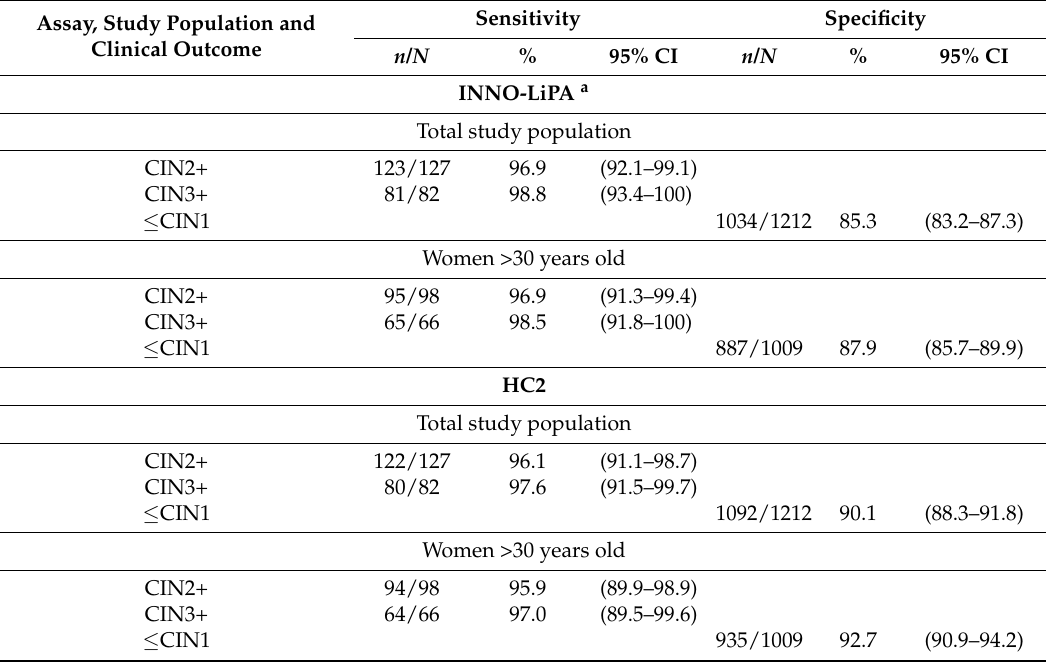
Table 2. Sensitivity of INNO-LiPA and HC2 for detection of CIN2+ and CIN3+ and specificity of both assays for detection of ≤ CIN1. Analysis was performed separately for the total study population and for women ≥ 30 years old.